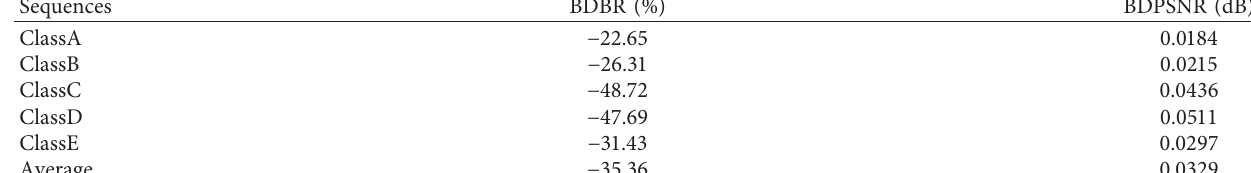
Table 6: Comparison of rate distortion performance by the ORC algorithm compared with the algorithm in [31].